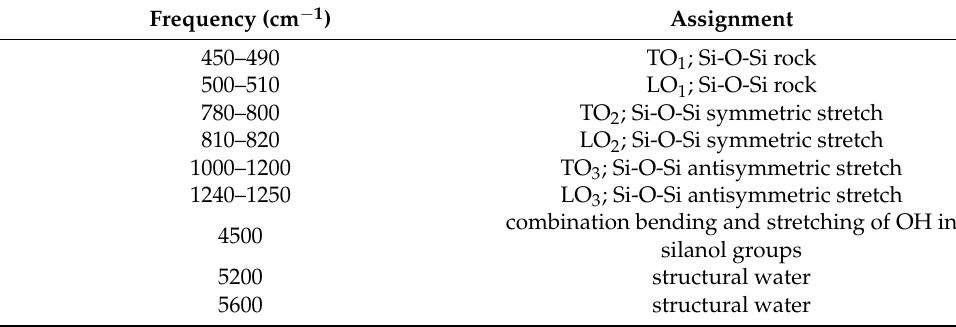
Table 3. Summary of infrared frequency variations in different opal types [8,9,20,21].